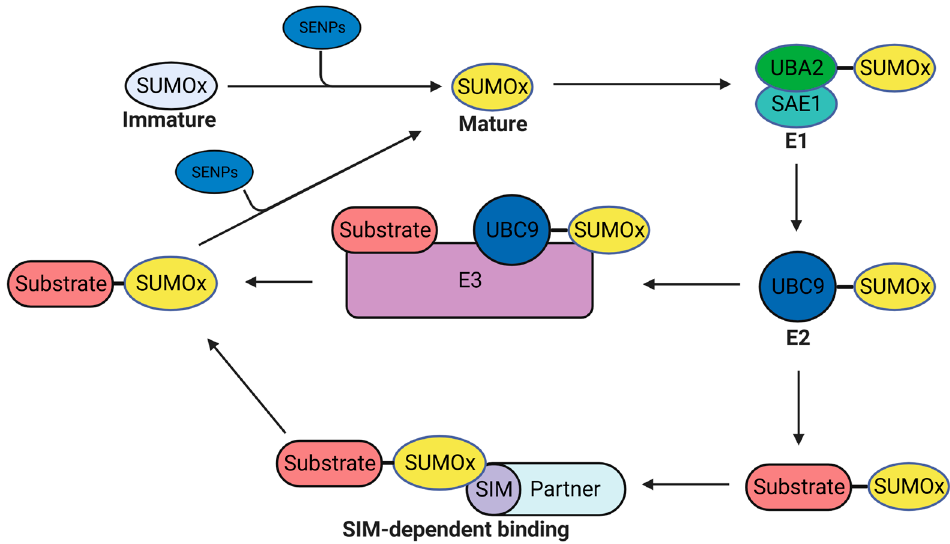
Figure 2. Schematic of the SUMOylation procedure. The immature precursor SUMO molecule is hydrolyzed by SUMO-specific proteases (SENPs) and processed into a mature form by presenting its C-terminal diglycine motif. Next, the mature form of SUMO is activated and transferred to the SUMO E2 enzyme UBC9 by the E1 enzyme complex (SAE1/UBA2). Then, UBC9 directly conjugates the SUMO molecule to the substrate protein or indirectly transfers the SUMO molecule to the substrate utilizing the SUMO E3 ligase. Most SUMO molecules on target proteins act as signals to interact with other partner proteins via the SUMO-interacting motif (SIM) presented on interacting proteins. The SUMO molecules can also be deconjugated from substrates by SENPs and reused by other protein substrates. SUMOx represents SUMO1, SUMO2, SUMO3, SUMO4, or